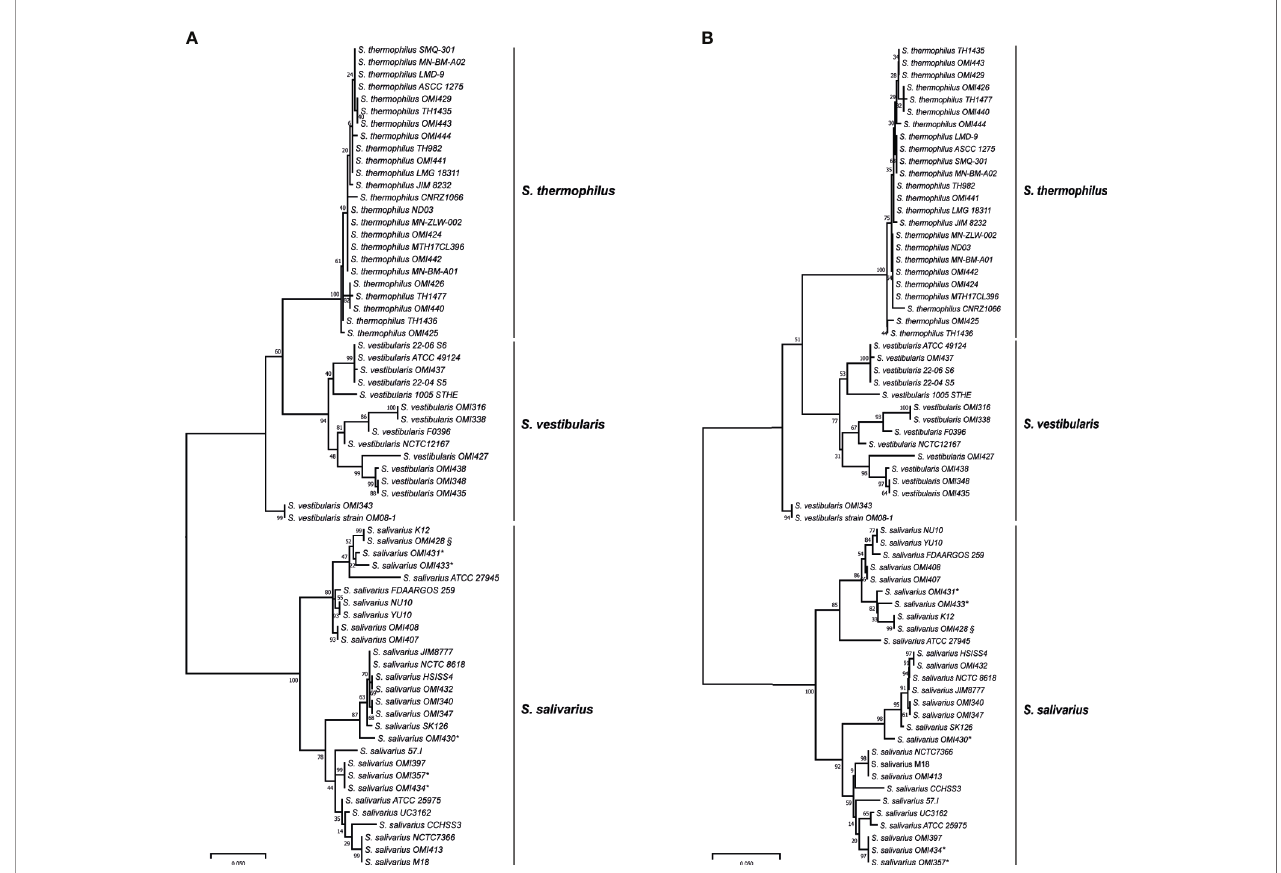
FIGURE 1 | Maximum likelihood (A) and neighbor-joining (B) phylogenetic trees based on the coaE gene sequence of 30 isolates (OMI) and from 37 publicly available salivarius group streptococci genomes imported from NCBI database. * represents isolates that were primarily assigned as “ S. vestibularis ” based on MALDI-TOF MS, while § shows a subculture of S. salivarius strain K12, OMI428, which was misidenti fi ed as “ S. vestibularis ” by MALDI-TOF MS. All these isolates were con fi rmed as S. salivarius by applying coaE gene typing, suggesting a wrong scoring order by MALDI-TOF MS. Tamura 3-parameter was used as substitution model with a discrete gamma distribution and bootstrap test of 1000